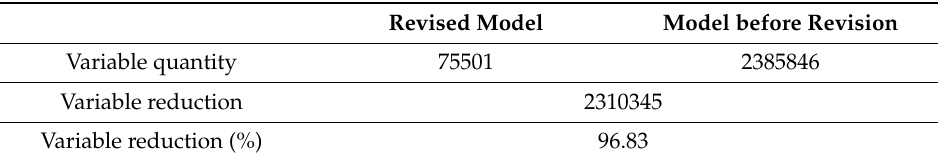
Table 4. Number of variables before and after convolution kernel correction.